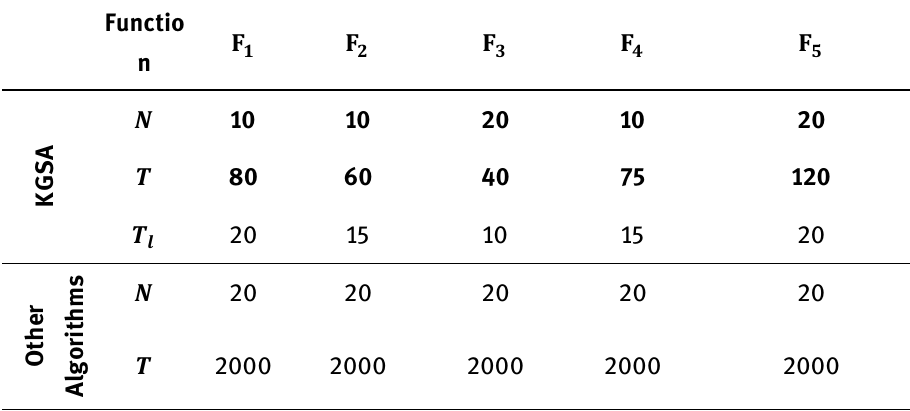
Table 5A: List of required parameters for discovering local and global optima in Tables 6, 7